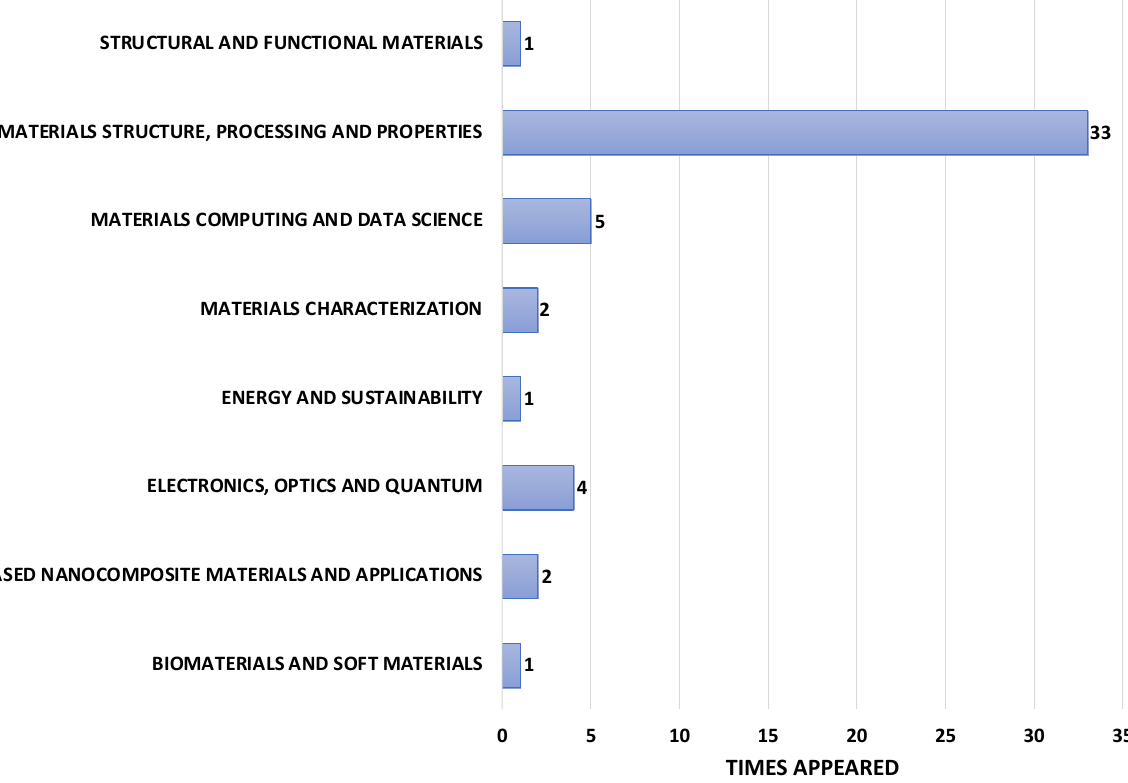
Figure 6. MSE area descriptive tags assigned to analyzed works and the number of times that these tags were used.